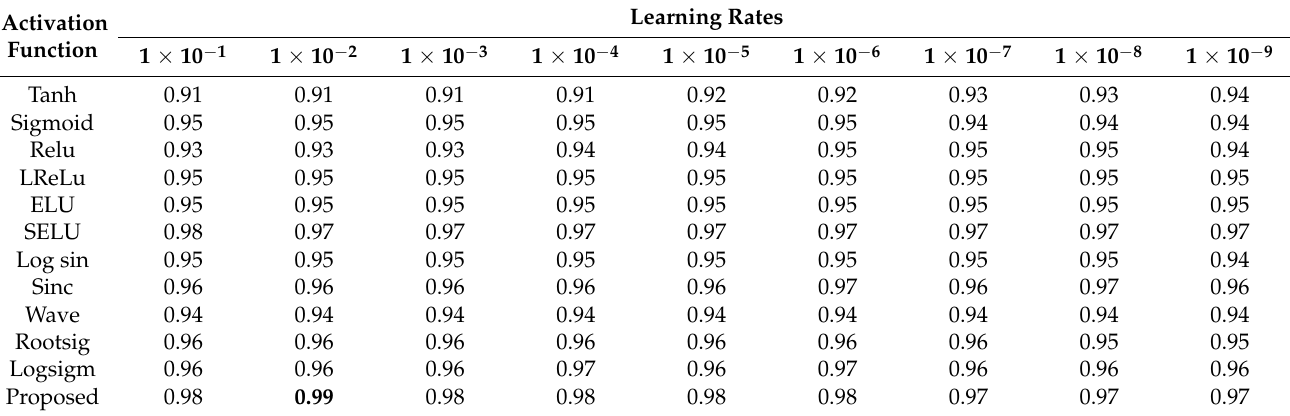
Table 3. Accuracy comparison of proposed function with others on different learning